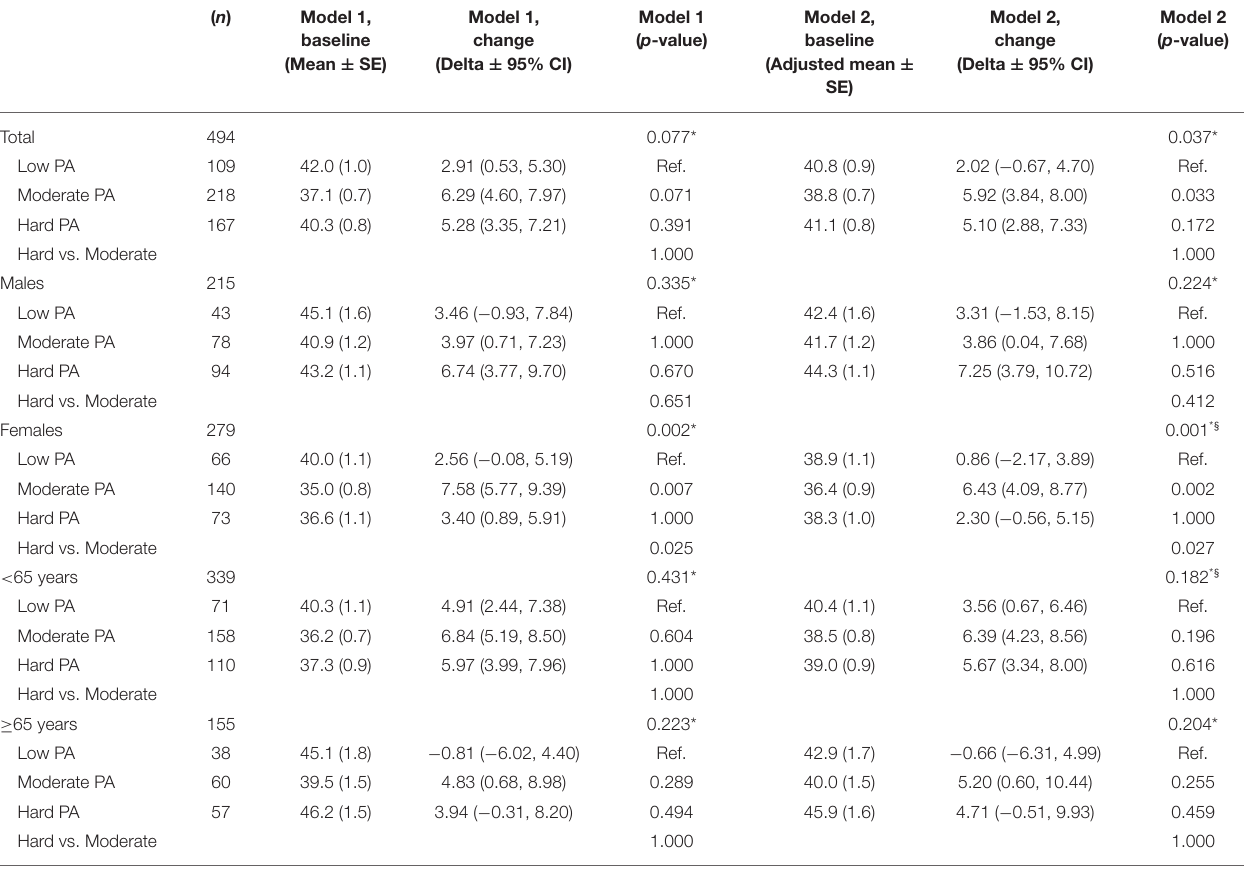
TABLE 3 | Longitudinal associations between cumulative physical activity and change in left ventricular mass index from baseline: The Tromsø Study